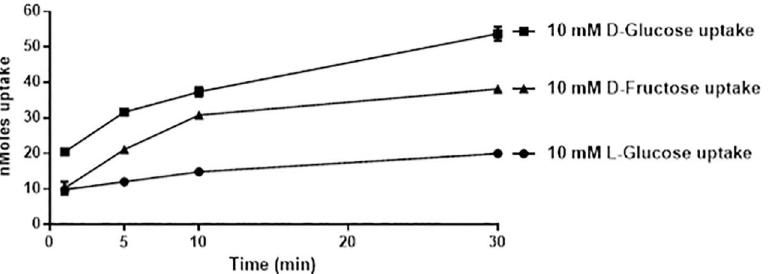
Fig 1. Time course of [14C] 10 mM D-Glucose, D-Fructose and L-Glucose uptake into Caco-2/TC7 cells. Caco-2/TC7 cells grown for 21 days were incubatedwith 10 mM sugar for 1, 5, 10 or 30 min and cellular uptake measuredby radioactive scintillation spectrometry. Data are expressedas nMoles sugar uptake/ well ± SD of n = 4 per condition.